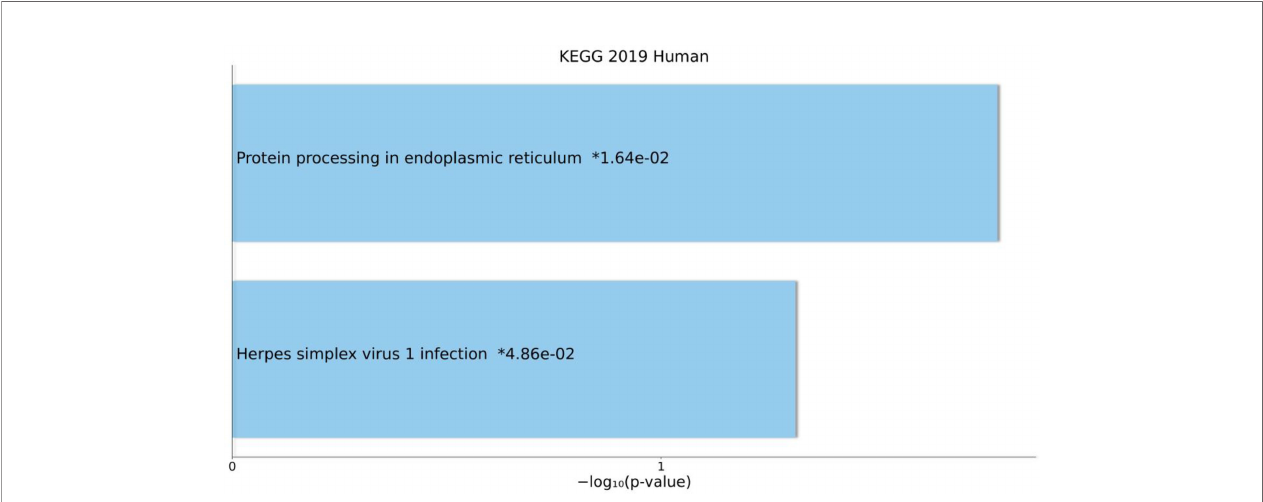
FIGURE 5 | Overall results of pathway enrichment analysis using Enrichr tool. The bar chart shows the enriched pathways, along with their corresponding P -values. Colored bars correspond to terms with signi fi cant P -values (<0.05). An asterisk (*) next to a P -value indicates the term also has a signi fi cant adjusted P -value